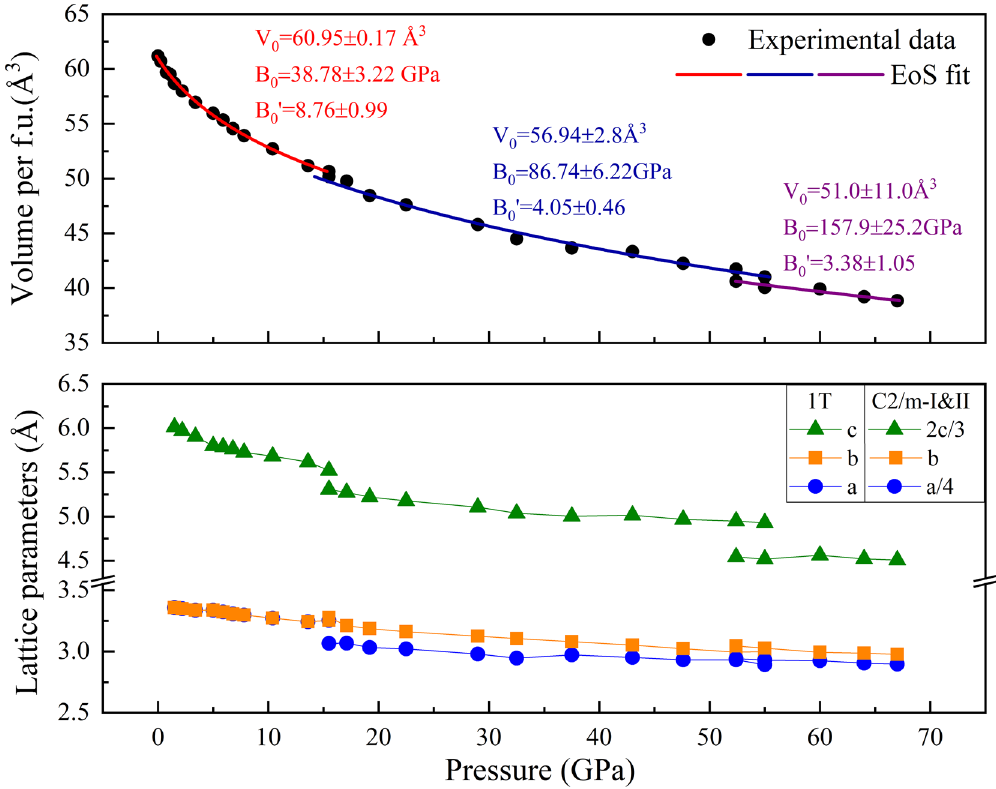
Figure 6. Pressure dependence of the unit cell volume, lattice constants a, b, and c for the VSe 2 in the pressure range of 0–67